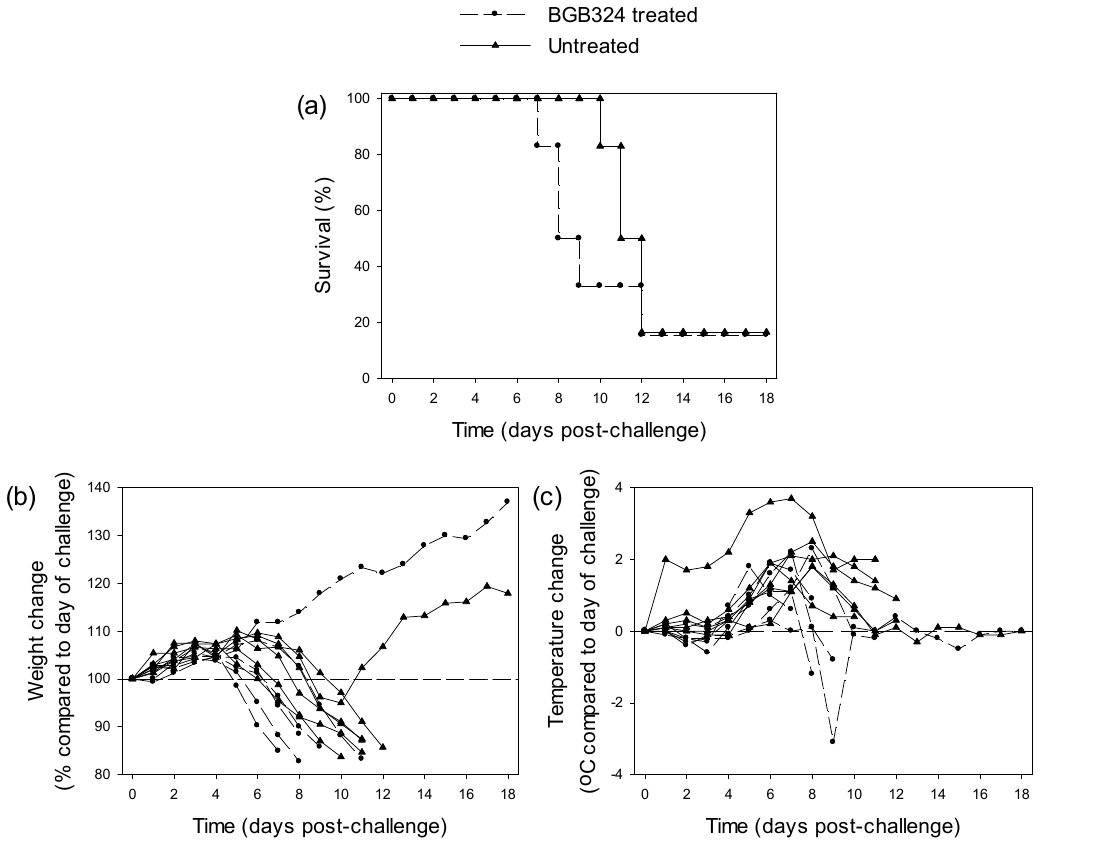
Figure 1. Survival and clinical parameters of guinea pigs treated with 100 mg/kg BGB324 twice daily compared to untreated controls ( n = 6 per group). ( a ) Survival analysis after challenge with 10 3 TCID 50 EBOV; ( b ) Weight changes as a percentage compared to the day of challenge; ( c ) Temperature changes as °C difference compared to the day of challenge.